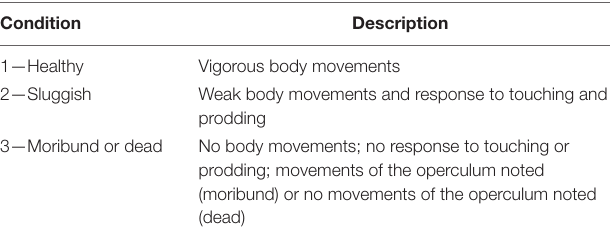
monthly evolution of the edge types (transparent or opaque) TABLE 1 | Classification of the condition of captured specimens (Benoît et al., 2010; Dapp et al.,